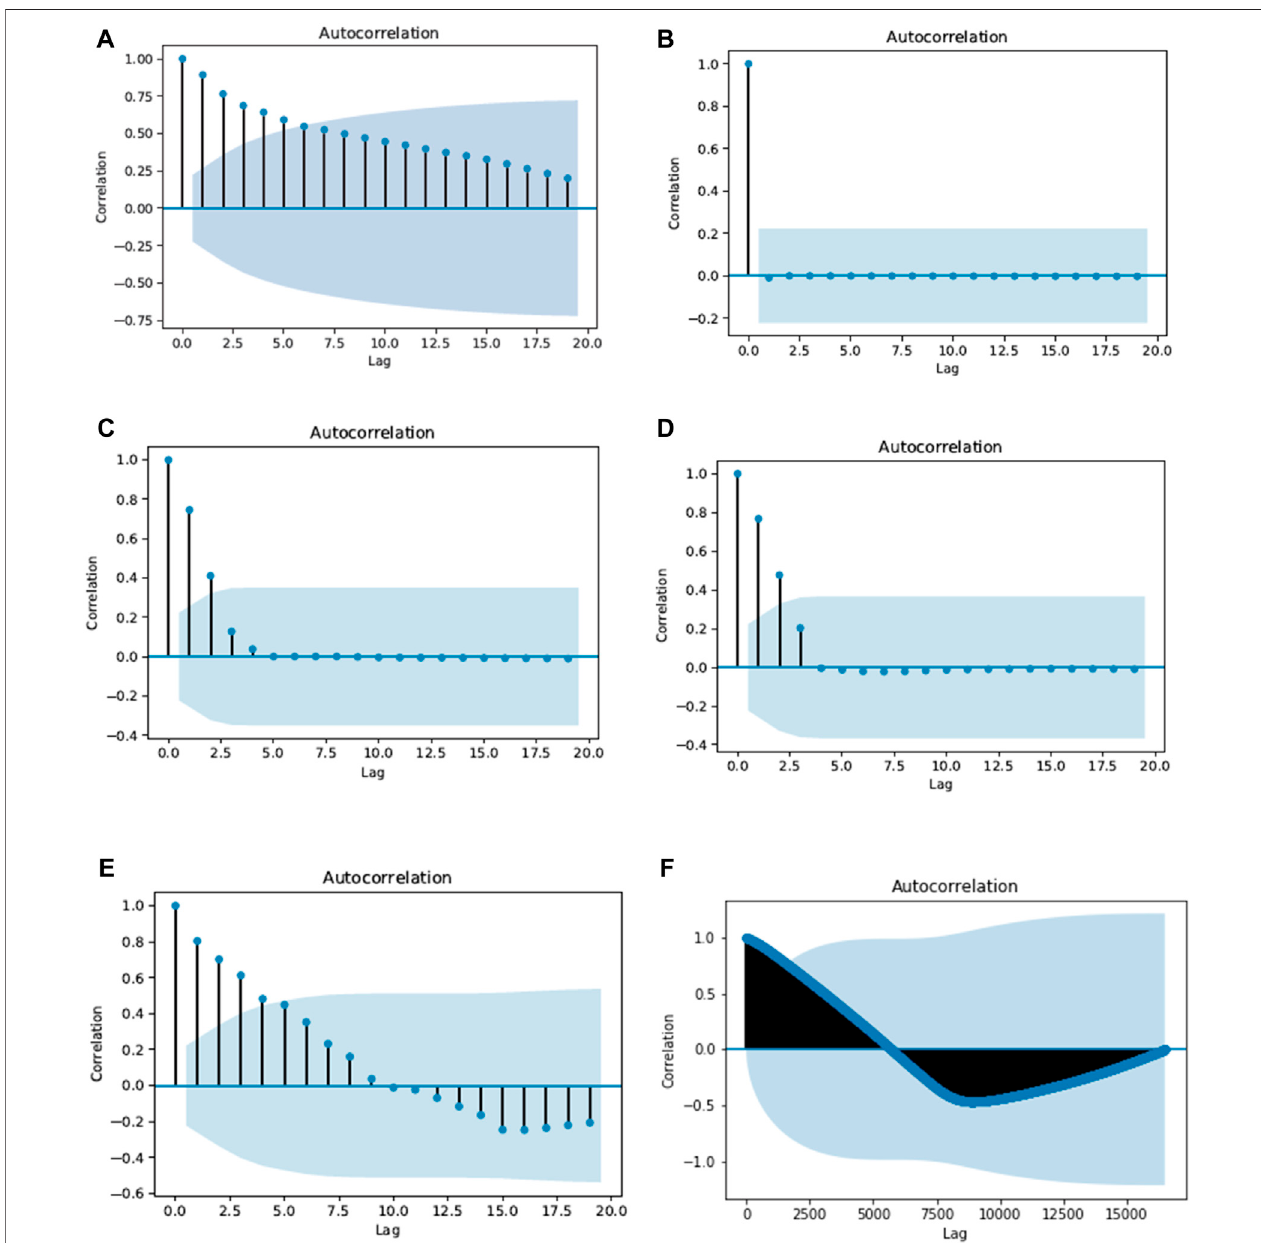
FIGURE 4 | The autocorrelation and partial autocorrelation plots with the 95% con fi dence interval. (A) Autocorrelation for sensor at 3 m in borehole one at Tangni. (B) Autocorrelation for sensor at 12 m in borehole two at Tangni. (C) Autocorrelation for the sensor at 6 m in borehole three at Tangni. (D) Autocorrelation for the sensor at 15 m in borehole four at Tangni. (E) Autocorrelation for the sensor at 15 m in borehole fi ve at Tangni. (F) Autocorrelations for the Kumarhatti data. (G) Partial autocorrelationforthesensorat3 minboreholeone atTangni. (H) Partialautocorrelationforthesensorat12 minboreholetwoatTangni. (I) Partialautocorrelation for the sensor at 6 m in borehole three at Tangni. (J) Partial autocorrelation for the sensor at 15 m in borehole four at Tangni. (K) Partial autocorrelation for the sensor at 15 m in borehole fi ve at Tangni. (L) Partial autocorrelations for the Kumarhatti data.